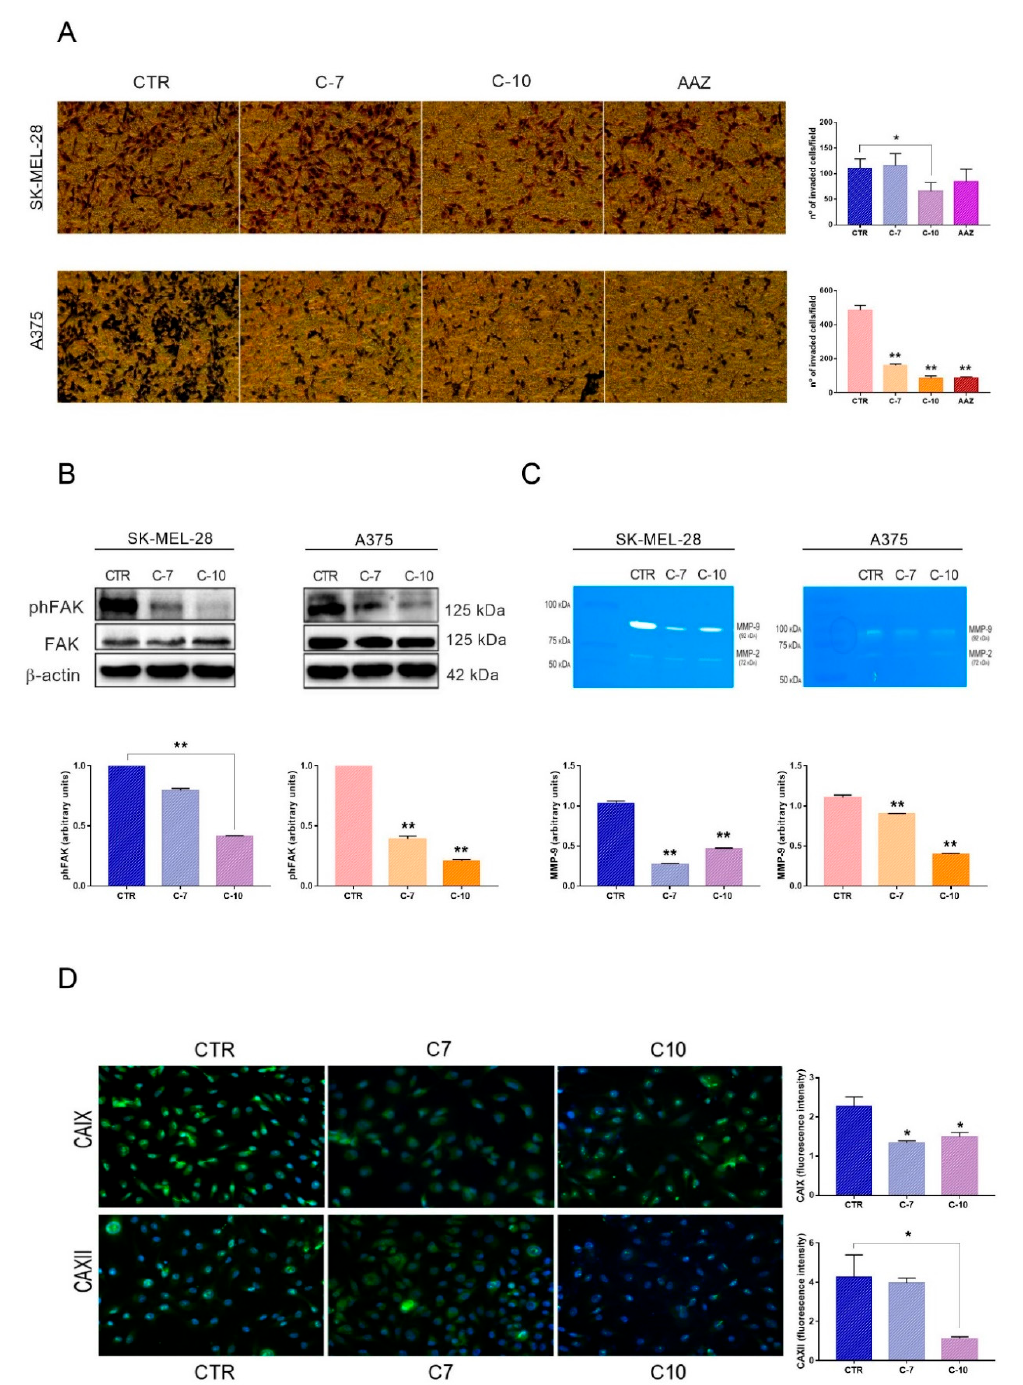
Figure 3. SK-MEL-28 and A375 invasion is reduced by direct CAXII inhibition under hypoxia. ( A ) Modified Boyden chamber invasion assays after pretreatment and 24 h treatment under hypoxia (10× magnification). Data are presented as the means and standard errors of the mean of three independent experiments performed in triplicates. Acetazolamide (AAZ) was used as control. ( B ) Phosphorylated focal adhesion kinase (phFAK) protein expressions after 24 h treatment with C-7 and C-10 under hypoxia as determined by western blot analyses. Data are presented as the means and standard errors of the mean of three independent experiments. B-actin was used as loading control. ( C ) Matrix metalloproteinase 9 (MMP-9) enzymatic activity after 24 h treatment upon hypoxia as determined by